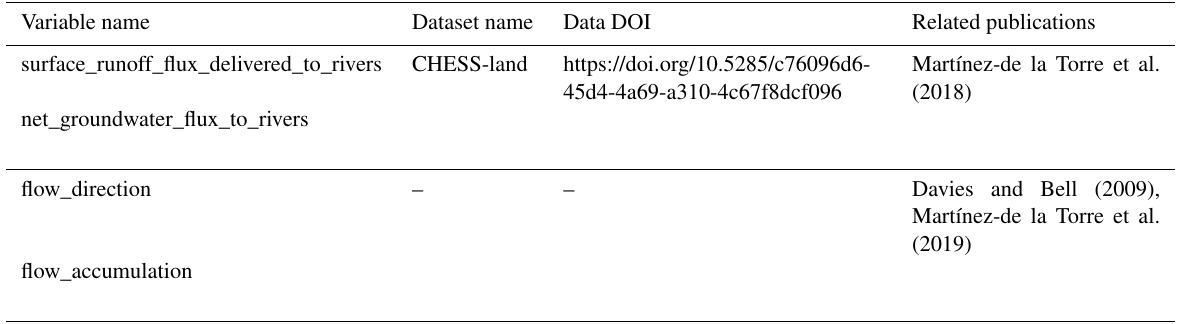
Table A2. Sources for data used in configuration 2.